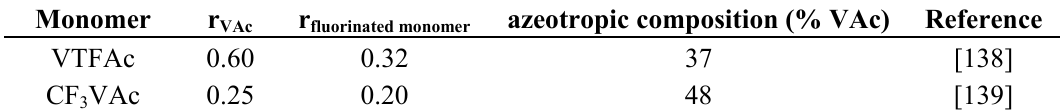
Table 1. Reactivity ratios of fluorinated vinyl esters in copolymerization with vinyl acetate